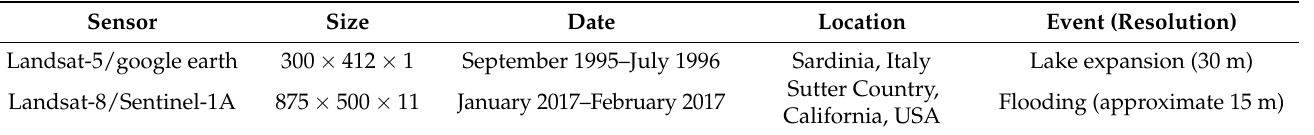
Table 2. Data set